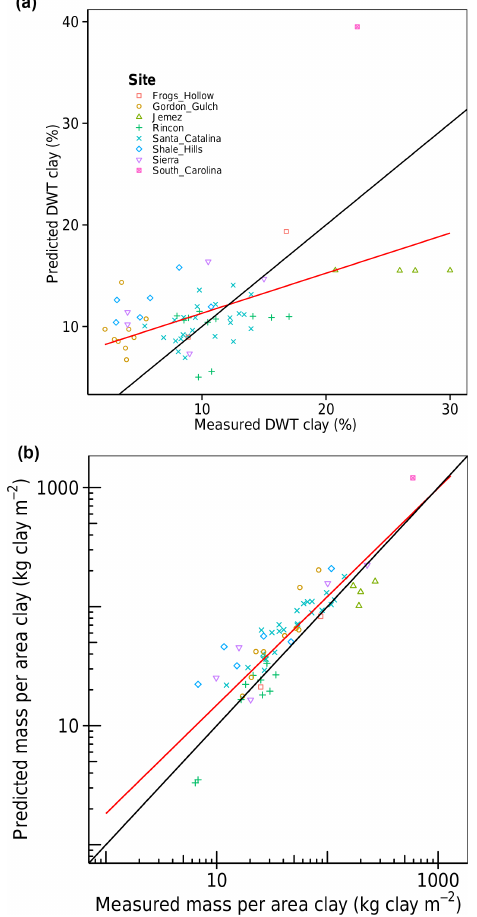
Figure 7. Model results in complex terrain. (a) Prediction of depth- weighted (DWT) clay contents; (b) prediction of mass per area clay using Eq. (9). The model was incapable of directly predicting DWT clay for the soils in complex terrain due to redistributive hillslope processes; r 2 = 0 . 26 between measured and predicted conditional mean DWT clay (a) . By including information about soil depth and percent volume rock fragment and converting DWT clay to mass per area clay, the model was significantly more effective at predicting clay contents for these soils r 2 = 0 . 81.